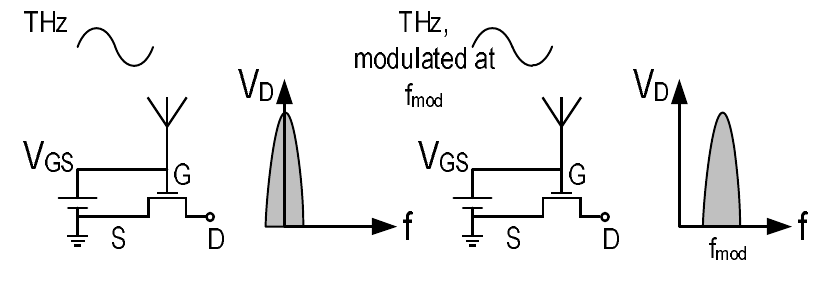
Figure 1. THz rectification with MOSFETs.